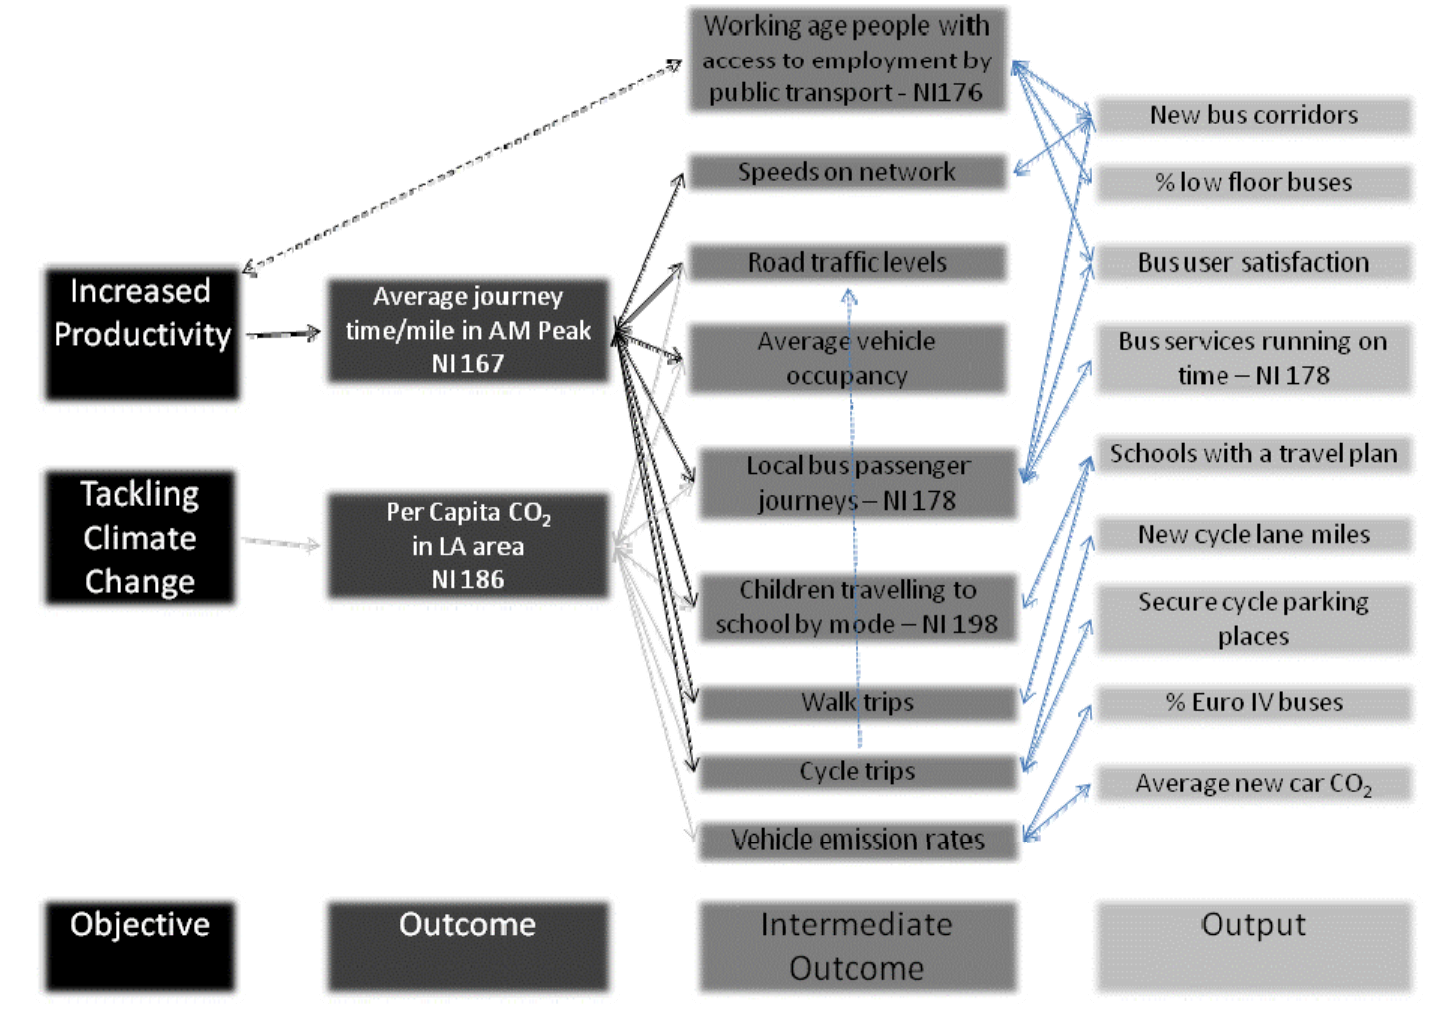
Figure 2. Example Indicator